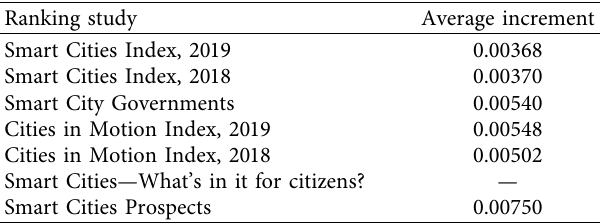
Table 10: Average increment of the normalized scores for the 7 ranking studies